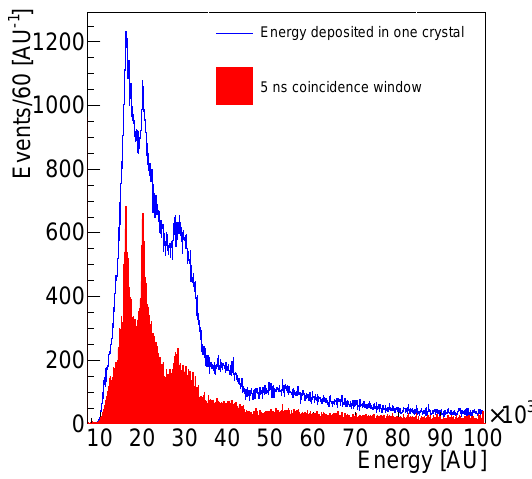
Figure 12. Histogram of the energy deposited in one of the crystals of the PET monitoring system during beam-on operation before (blue line) and after (filled red) 5 ns time coincidence.